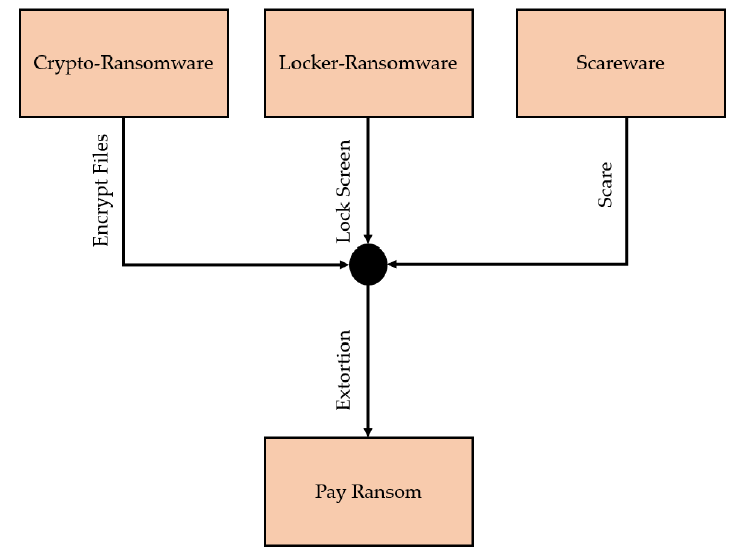
Figure 2. Types of